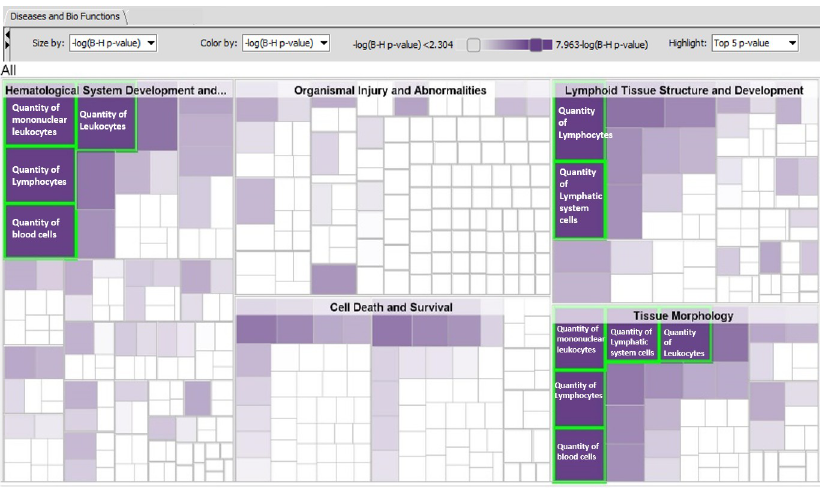
Fig 7. Hierarchical heatmap with diseases and bio-function category and top 5 high level functions are displayed and labeled inside the highlighted green border. The visualization is a TreeMap (hierarchical heatmap) where the major boxes represent a family (or category) of related functions. Each individual colored rectangle is a particular biological function or disease and the color indicates associated log of the calculated BH corrected p-value: lower p value (purple), or higher p value (white). Darker colors indicate lower p values. In this default view, larger squares indicate more significant overlap between the genes perturbed in the dataset and the function or disease. The image has been cropped for better readability. Here data from whole blood when frozen vs. cold conditions are compared using top 1000 FDR corrected DEGs was used.